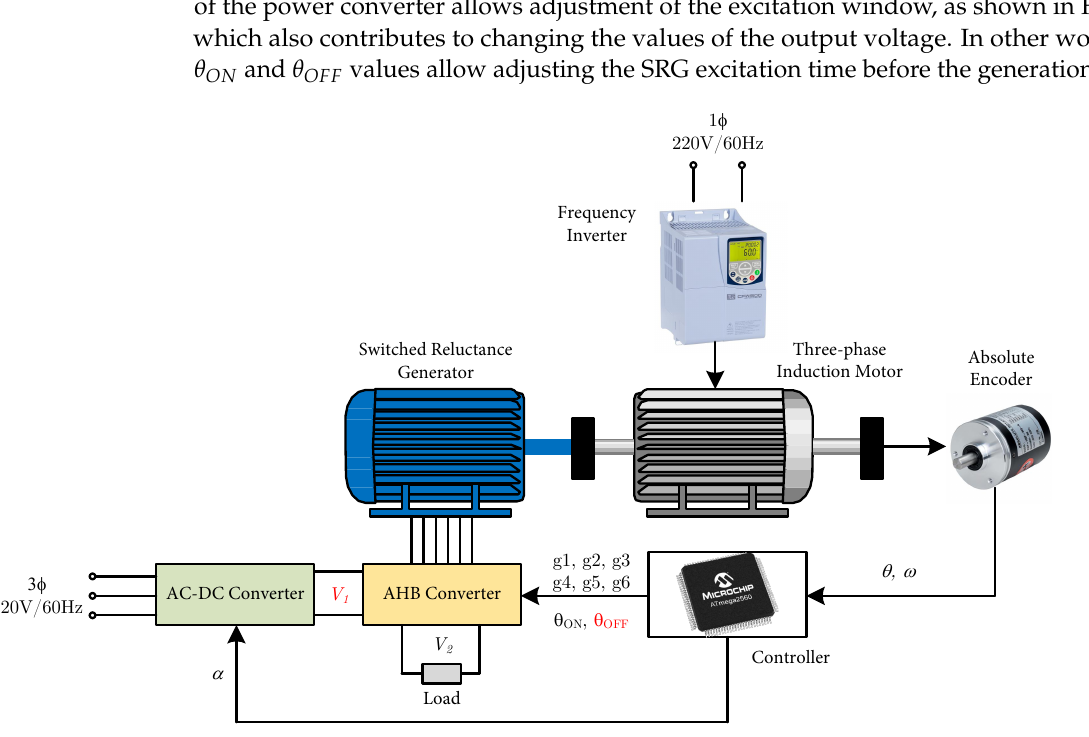
Figure 5. Closed-loop system diagram for direct power